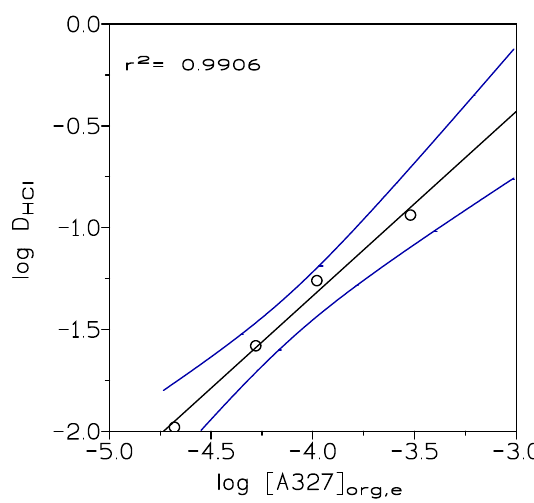
Figure 1. Hydrochloric acid extraction by A327 solutions (0.5–5% v/v) in Solvesso 100. Temperature: 20 °C. Equilibration time: 10 min. Organic/Aqueous phases relationship: 1. Dotted line showed the 95% confidence interval of the regression line.